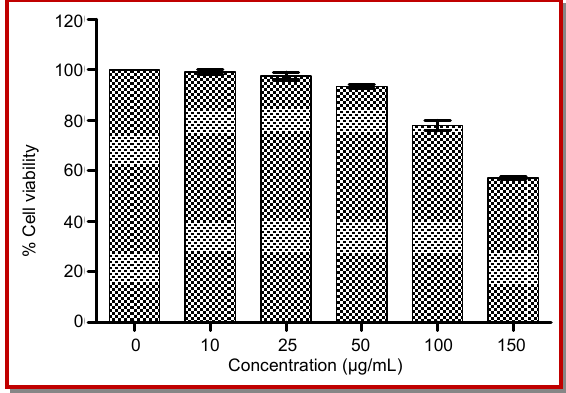
Figure 1: Percentage of cell viability at various concentrations of ethyl acetate extract of the endophytic fungus C. cupreum